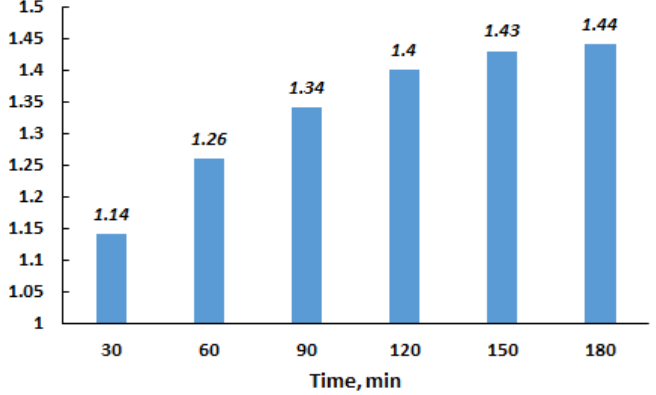
Figure 8. Influence of the time interval between quartz milling and the use as a demulsifier on a relative decrease in the demulsification